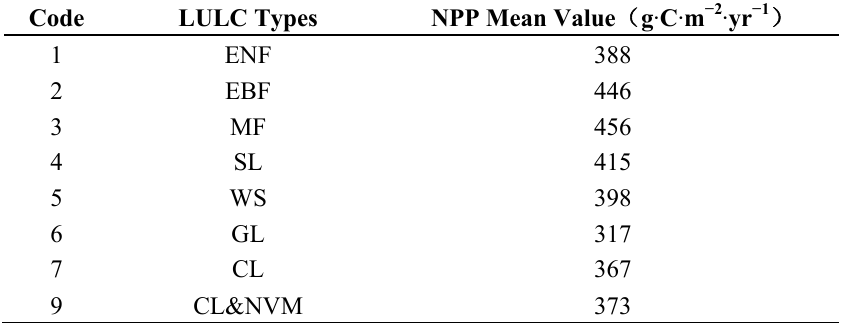
Table 2. Net primary productivity (NPP) mean values of the land use/land cover types in Guangzhou.